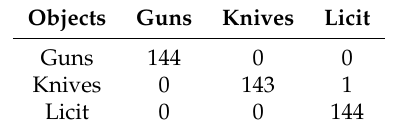
Table 11. Confusion matrix of licit/non licit object classification, for the best parameters at frequency 92 GHz. Objects Guns Knives Licit Guns 144 0 0 Knives 0 143 1 Licit 0 0 144